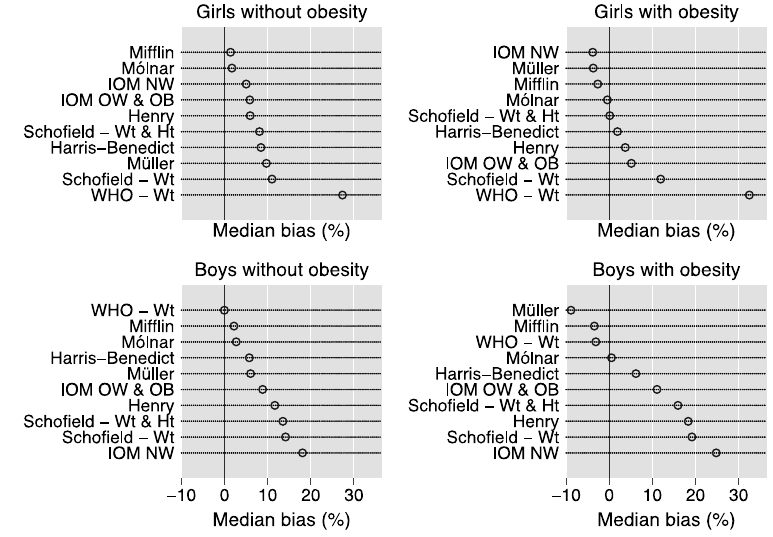
Figure 1. Median percent bias of the REE prediction equations. Dot charts showing the median percent bias of the REE prediction equations in the 2426 children stratified by sex and obesity. Percent bias is calculated as [(estimated REE-measured REE)/measured REE]*100. Abbreviations: WHO = World Health Organization; Wt = weight; Ht = height; IOM = Institute of Medicine; NW = (equation for) children with normal weight; OW = (equation for) children with overweight; OB = (equation for) children with obesity.